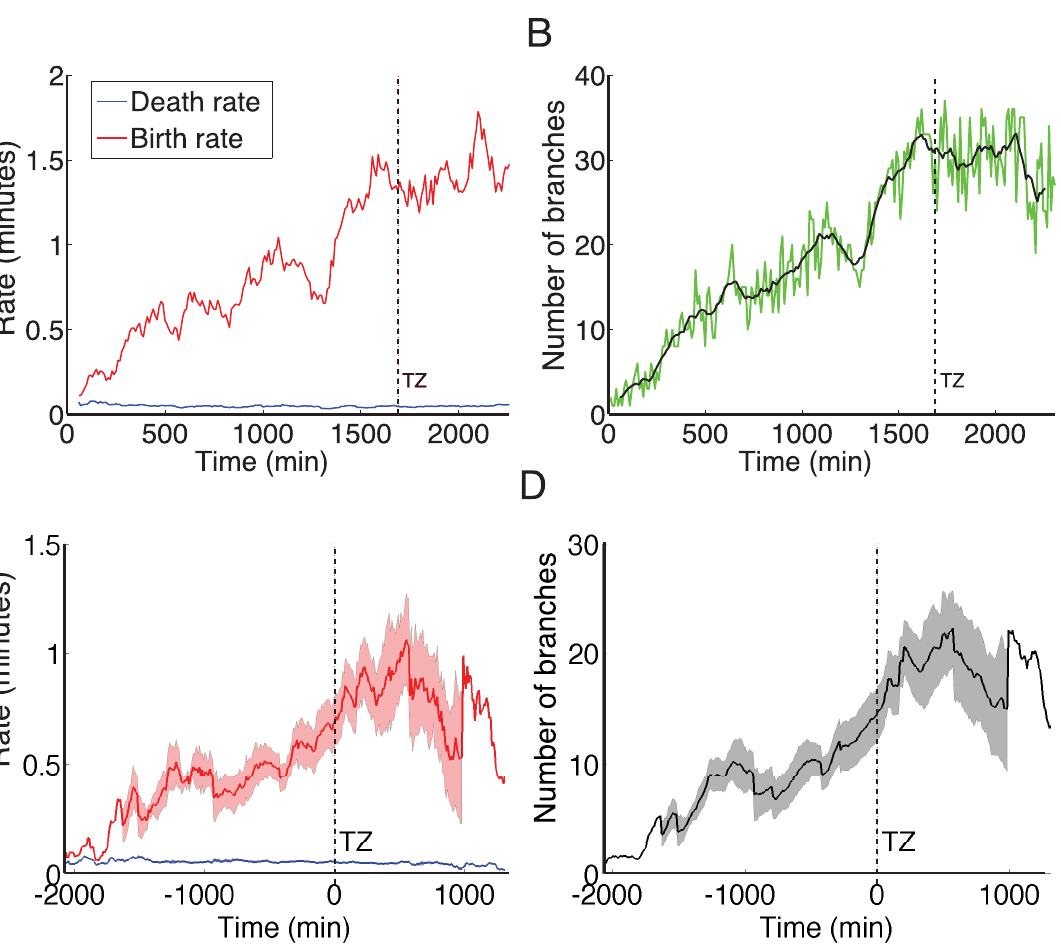
Fig 5. The branching rate estimates over time showed that the branch birth rate increased prior to the axon reaching the TZ. (A): A typical example control axon where the death rate (blue) was relatively constant compared to the birth rate (red). There was an increase in the branch birth rate before the axon reached the TZ, at which point the rate became more constant. (B): The number of branches (green) of the axon in (A), and the moving average of the branch number (black) with a window of 100 minutes. The number of branches followed a similar pattern to the birth rate. (C): The averaged rates over all control axons, after times were aligned such that zero was the point the TZ was reached. Mean branch birth rate (red) with shaded SEM showed that the birth rate peaked after the TZ was reached. The average death rate (blue) stayed relatively constant, with a SEM too small to be visible. (D): The average number of branches for all axons over time, with shaded SEM, reflected the increase in the birth rate of branches.